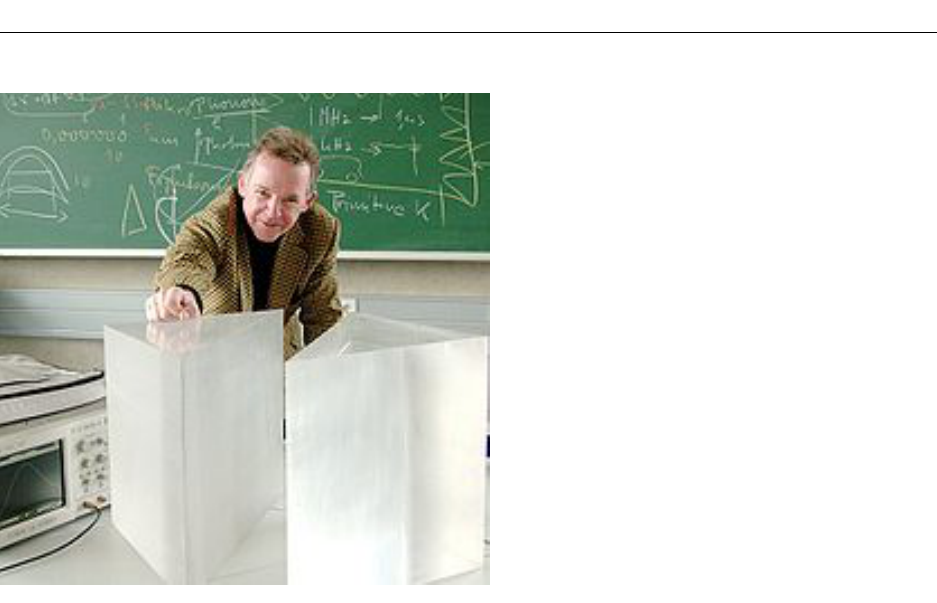
Figure 5. Günter Nimtz in the Physics laboratory of the University of Koblenz, 2008. Taken from [51].